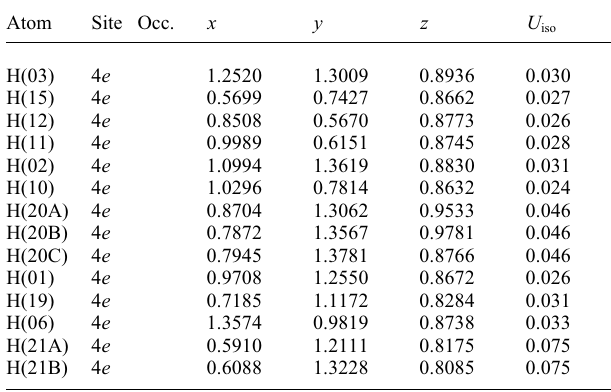
Table 2. Atomic coordinates and displacement parameters (in Å 2 )